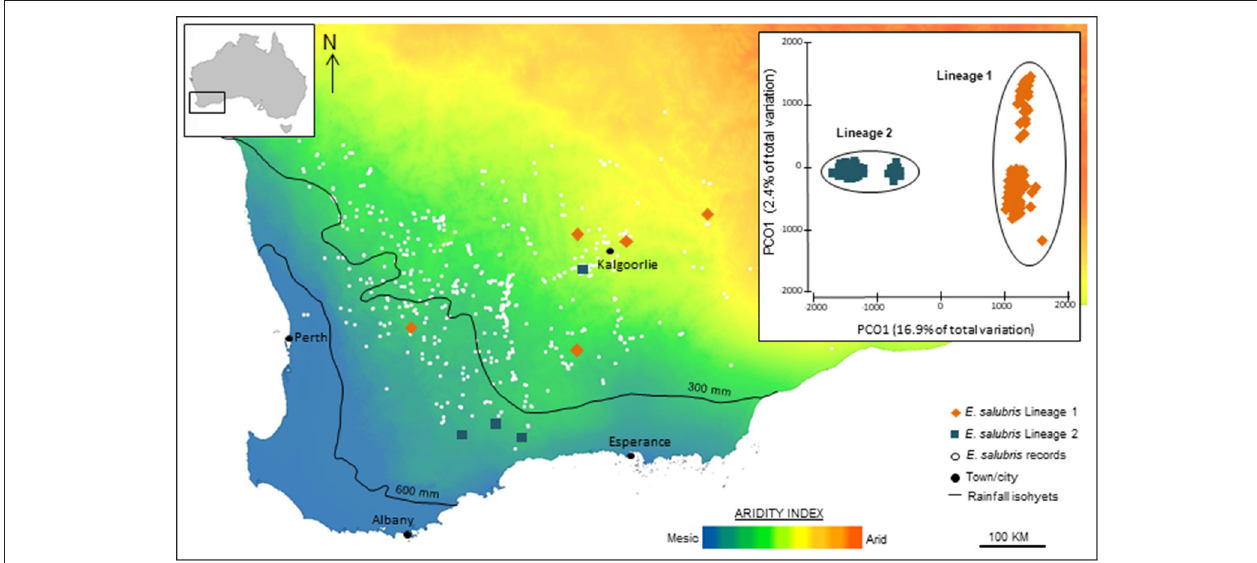
FIGURE 3 | Genomic analysis using SNP data identified cryptic lineages in the widespread Eucalyptus salubris . The location of samples populations of each lineage are shown across an aridity index gradient in south west Western Australia. The PCoA based on binary genetic distances derived from 16,122 DArTseq markers, shows two distinct lineages. Adapted from Steane et al.